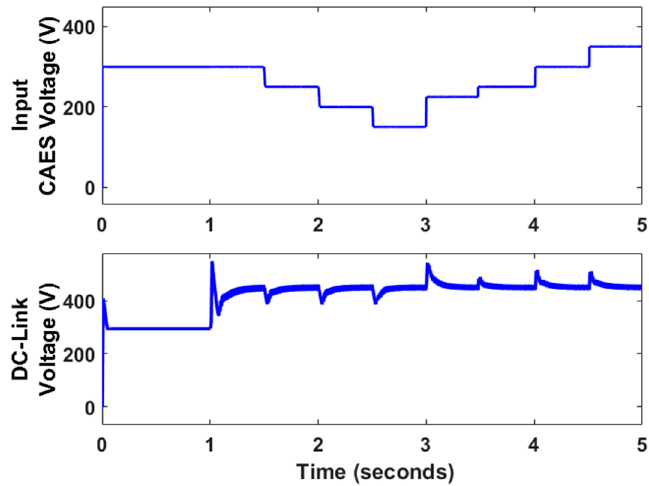
Figure 6. Input CAES voltage and DC-link voltage for boost converter.